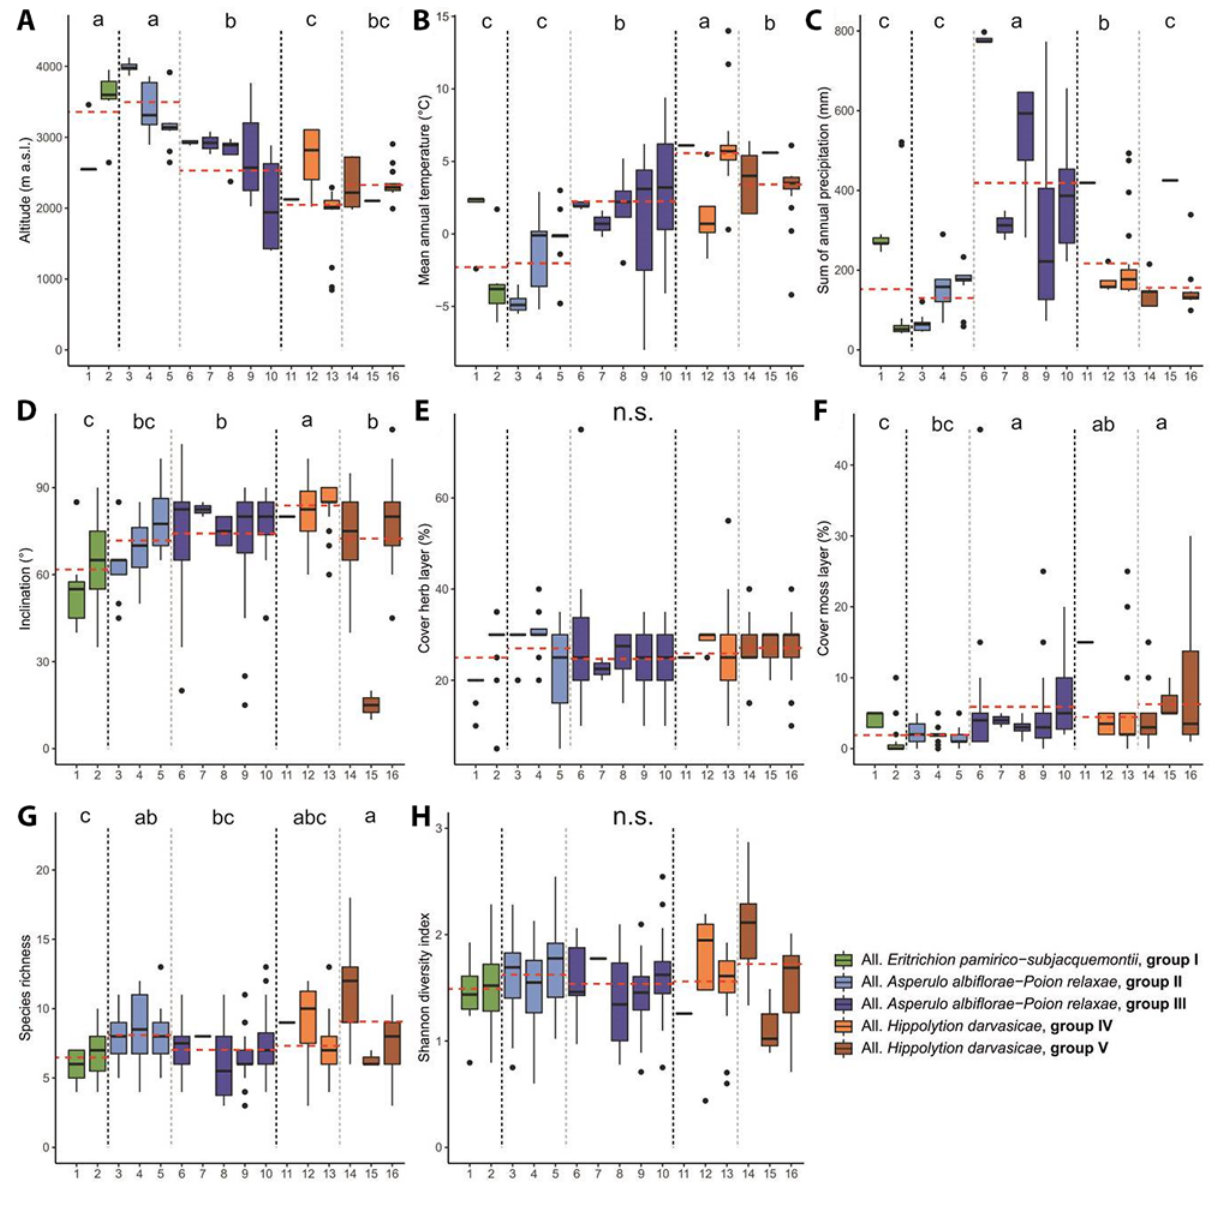
Figure 4 Boxplots showing median (line), quartiles, outliers and the range of ( A ) altitude, ( B ) mean annual temperature, ( C ) sum of annual precipitation, ( D ) inclination, ( E ) cover of herb layer, ( F ) cover of moss layer, ( G ) species richness, ( H ) Shannon diversity index for particular syntaxonomical units. Red line indicates mean values of vegetation groups. e values of 𝜒 2 and p for statistical tests for vegetation groups are shown in Table 1. Different letters indicate significant differences among the vegetation groups. e abbreviations of the syntaxonomical units are explained in synopsis and Figure